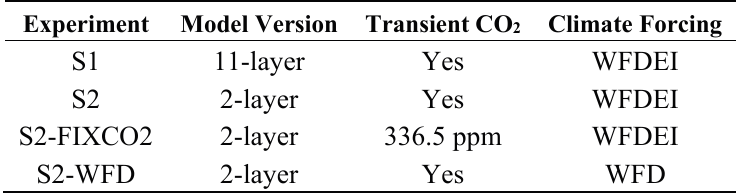
Table 1. Overview of the ORganizing Carbon and Hydrology In Dynamic EcosystEms (ORCHIDEE) simulations analyzed in this